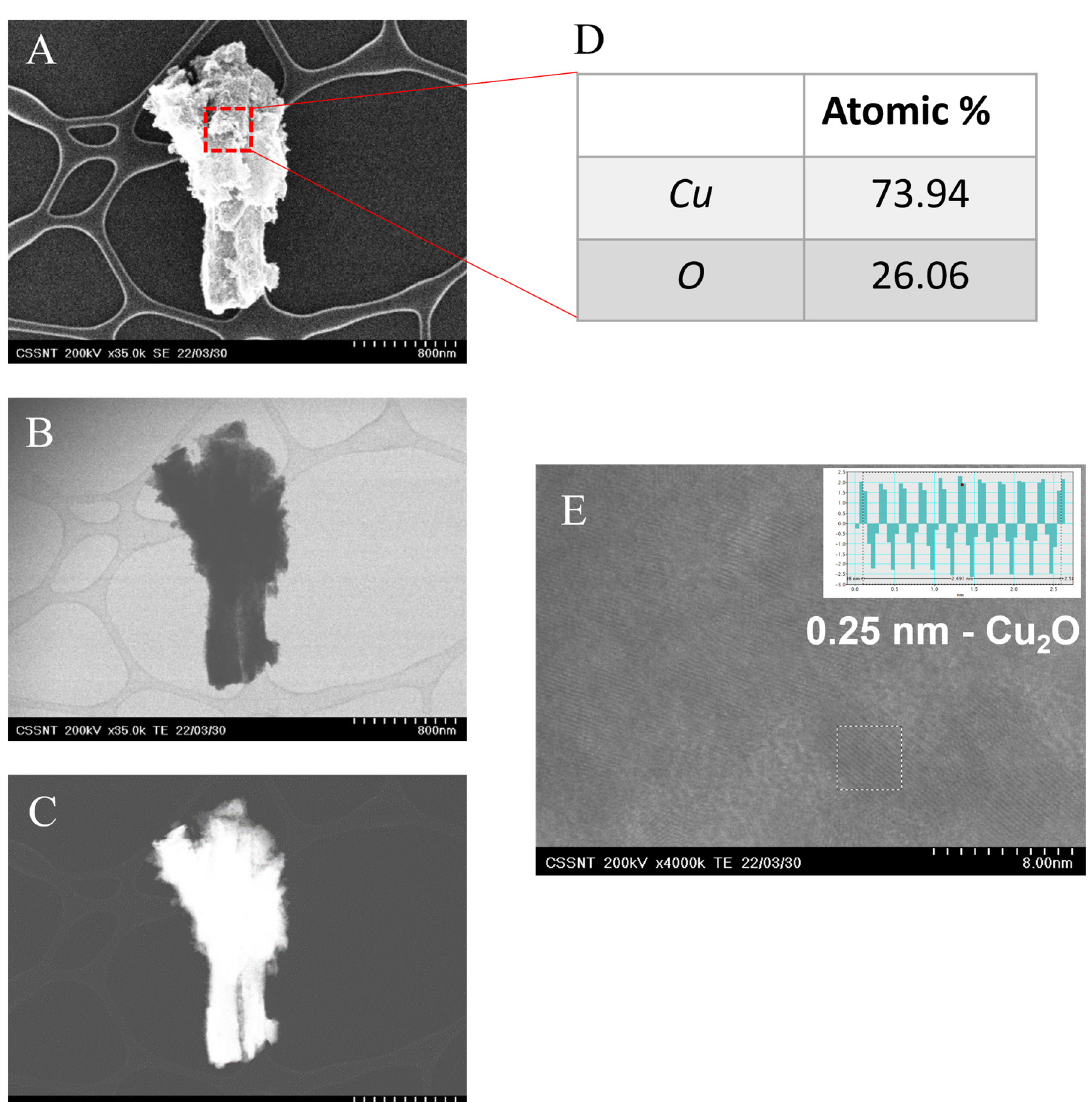
Figure 5. HR-STEM micrographs in ( A ) SEM, ( B ) TEM, and ( C ) ZC mode; ( D ) EDX analysis and ( E ) interplanar space